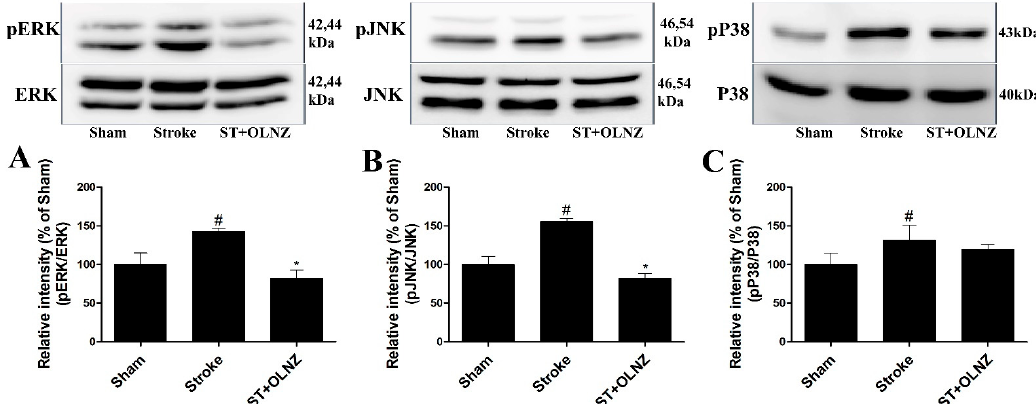
Figure 6. Protective role of OLNZ against the TI-mediated phosphorylation of ERK, JNK, p38 protein in the brain. The expression (% of sham) of ( A ) pERK, ( B ) pJNK proteins decreased significantly, and ( C ) pP38 proteins also decreased but not significantly after treatment with OLNZ in TI-induced gerbil hippocampus. Data were expressed as the mean ± SEM, n = 3/group. After performing a one- way ANOVA with Tukey’s post hoc test, p < 0.05 for comparisons of treatment groups with the sham group (#) and p < 0.05 for comparisons with the stroke group (*) were considered significant.